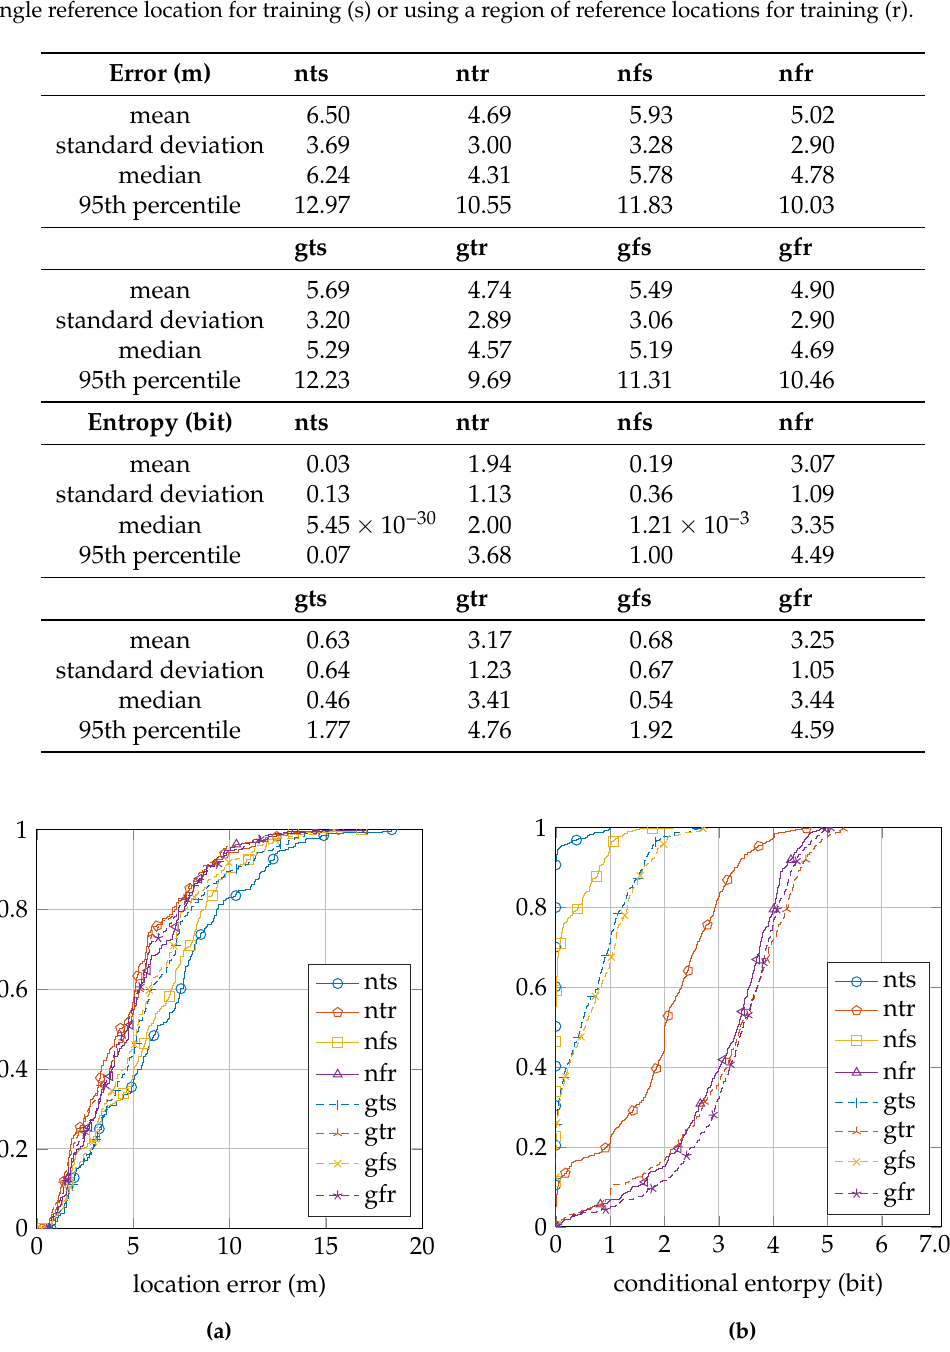
Table 4. GEOTEC summarizing table. The column labels refer to using the normal sensor model (n) or using the convolution sensor model (g), using the trained σ (t) or using the fixed σ (f) and using a single reference location for training (s) or using a region of reference locations for training (r).